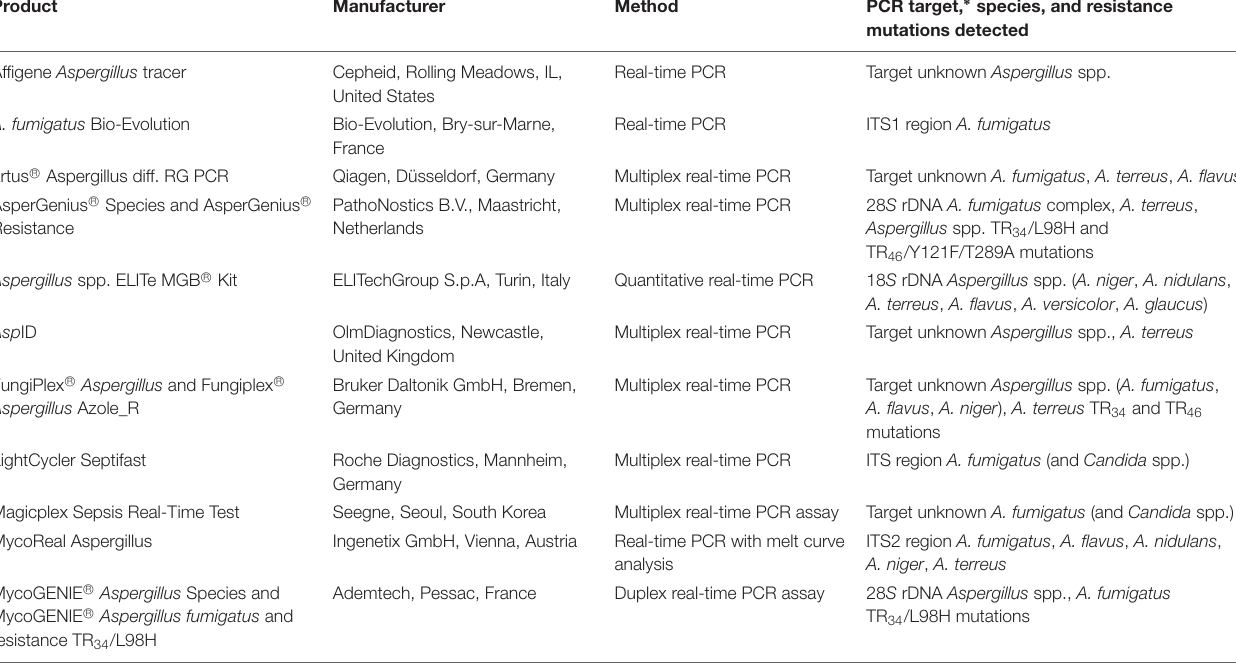
TABLE 1 | List of commercially available PCR-based assays for detection of Aspergillus spp. and CYP51A resistance mutations in A. fumigatus